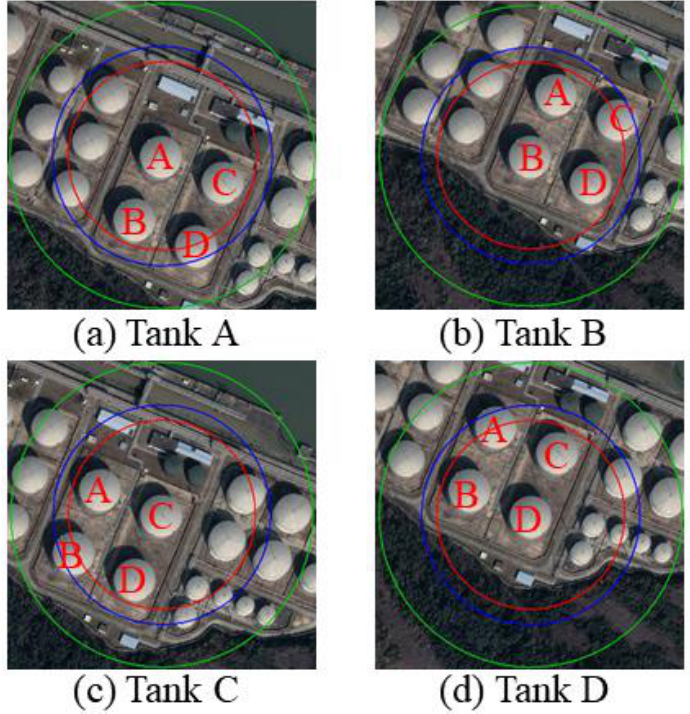
Figure 12. Casualty radius of tank pool fire.